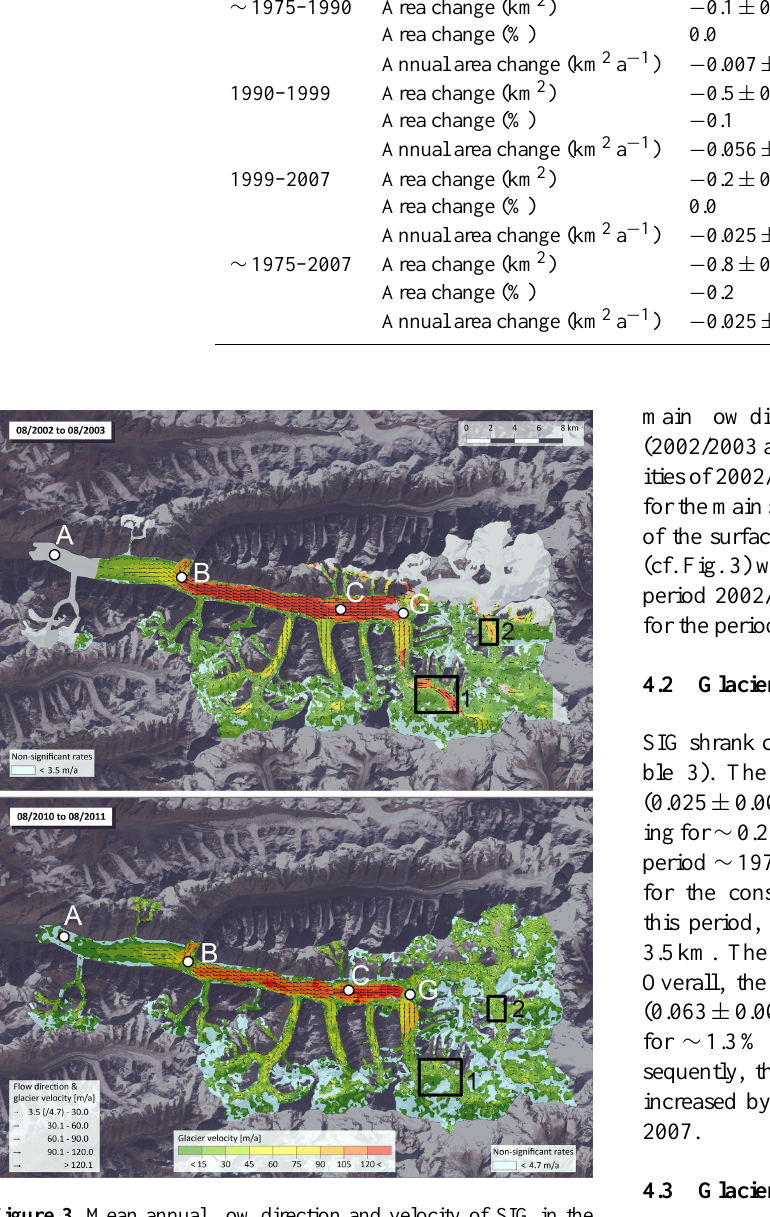
2010/2011 (Fig. 3). A significant acceleration was observed from point B to the lake dam. These results are in agreement with Nobakht et al.